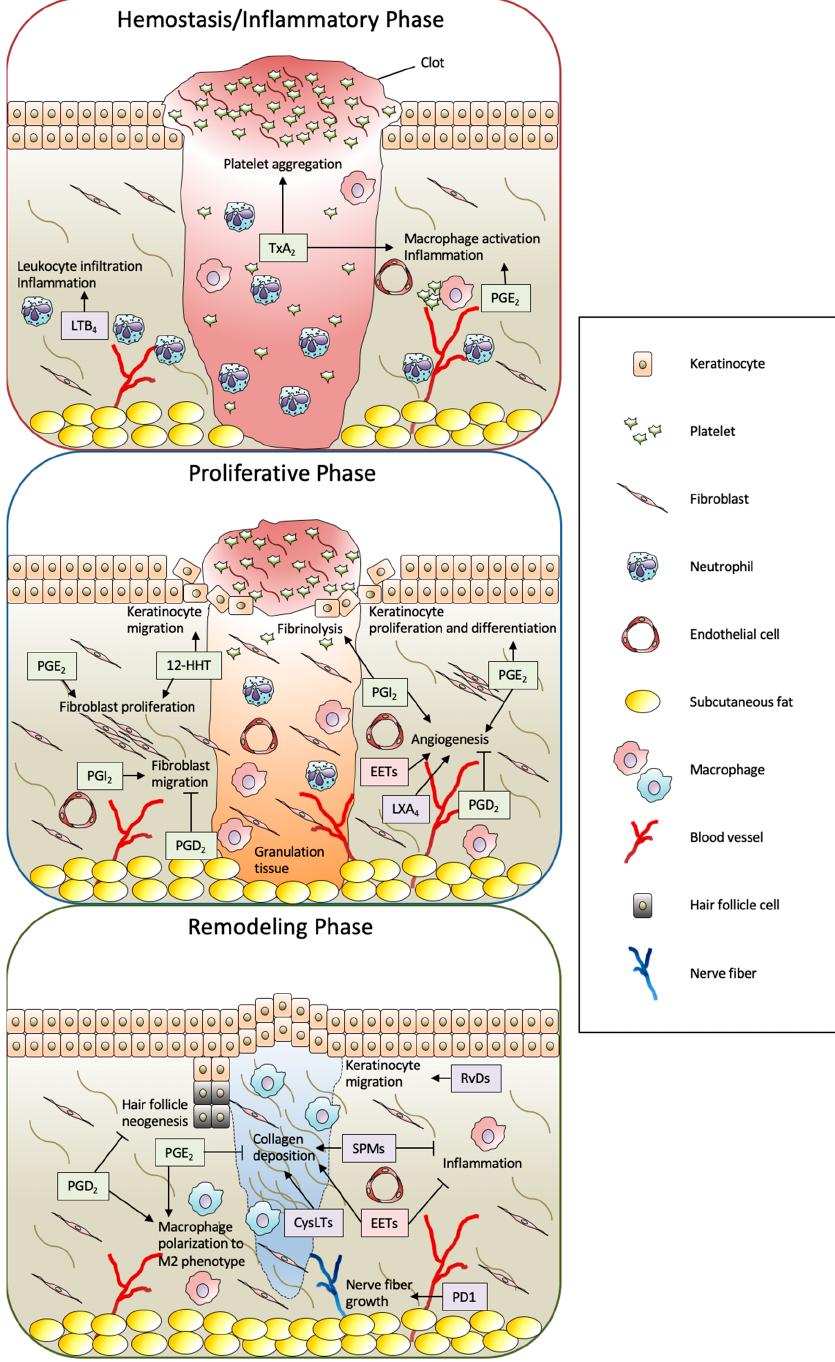
Figure 3. Summary of biological functions of eicosanoids and SPMs in full-thickness wound healing. The process of skin wound healing consists of three consecutive and overlapping steps, including hemostasis / inflammatory, proliferative, and remodeling phases. In this process, a wide variety of eicosanoids and SPMs are produced from skin-resident cells and infiltrated cells by the wound stimuli and play multiple roles. The metabolites formed by the COX, LOX, and CYP pathways are shown as green, purple, and red boxes, respectively. PG: prostaglandin; Tx: thromboxane; LT; leukotriene; 12-HHT: 12( S )-hydroxyheptadeca-5 Z ,8 E ,10 E -trienoic acid; EET: epoxyeicosatrienoic acid; LX: lipoxin; Rv: resolvin; PD1: protectin D1; SPM: specialized pro-resolving mediator; CysLT: cysteinyl